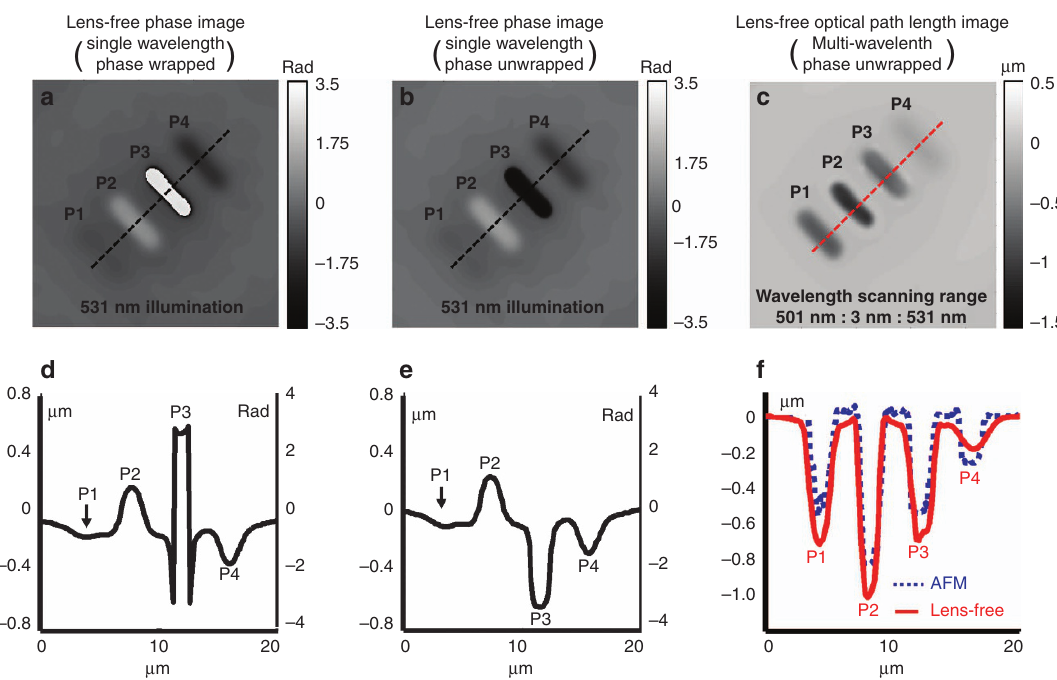
Figure 8 Phase unwrapping using multiple wavelengths. The sample consists of four grating lines carved into a glass substrate using focused ion beam milling. ( a ) Lens-free phase image obtained using a single wavelength; phase map is wrapped. ( b ) Unwrapped lens-free phase image obtained from a single wavelength reconstruction using a two-dimensional phase unwrapping technique based on minimum network fl ow 36 . ( c ) Unwrapped lens-free phase image obtained using reconstructions from multiple wavelengths. Eleven wavelengths are used within a scanning range of 501 – 531 nm and a scan step size of 3 nm. Refer to the Materials and Methods section for further details on multi-wavelength phase unwrapping. ( d – f ) Depth pro fi les of a – c, respectively. The blue dashed line in f is the depth pro fi le of the sample gratings measured using an atomic force microscope (AFM).